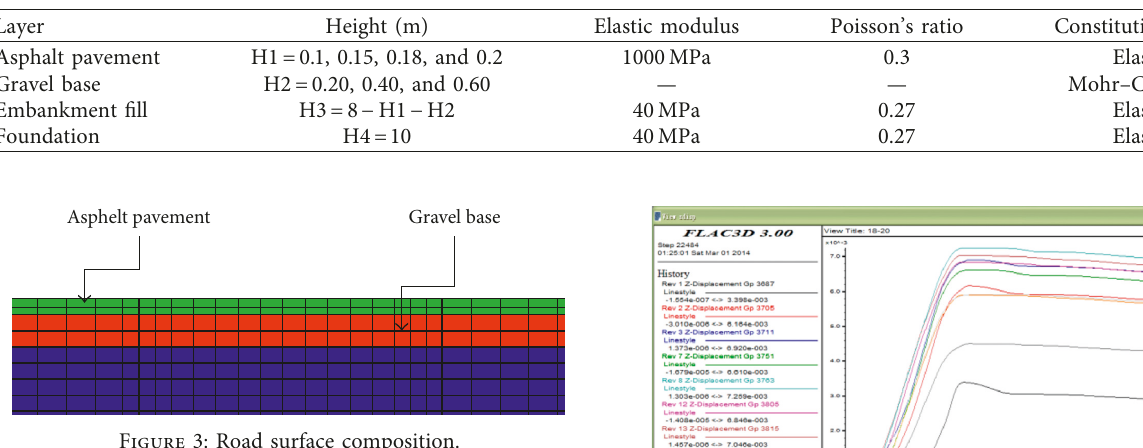
Figure 2: Model size in Table 1: Parameters for the embankment model.